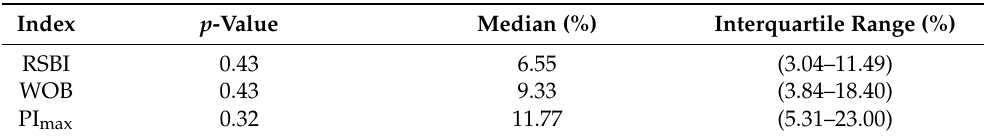
Figure 8. Comparison between experimental data and the predicted results produced by the models, according to input parameters of I: E, RR, P musc , C, and R of each subject for ( I ) RSBI, ( II ) WOB, and ( III ) PI max . Table 7. Percentage of error and p-values between experimental and predicted data for each of the evaluated indexes of the “Work of Breathing Indexes” module.